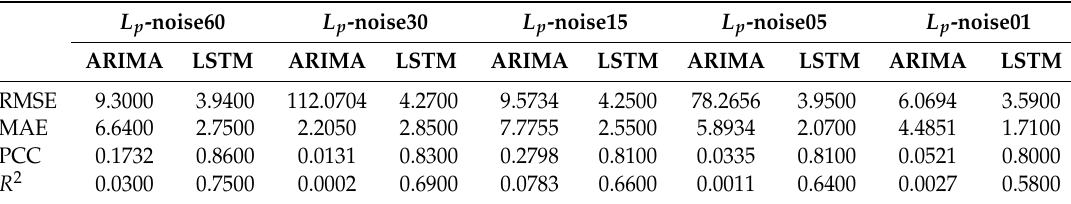
Table 3. Representation of Root Mean Square Error (RMSE), Mean Absolute Error (MAE), Pearson Correlation Coefficient (PCC) and R 2 of the five data-sets of sound pressure level values ( L p ) for the LSTM proposed models and the ARIMA models.